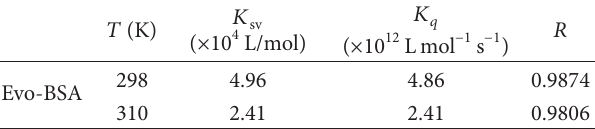
T 1: Stern-Volmer quenching constants for BSA interaction with Evo, is the correlation coefficient. 𝑅𝑅